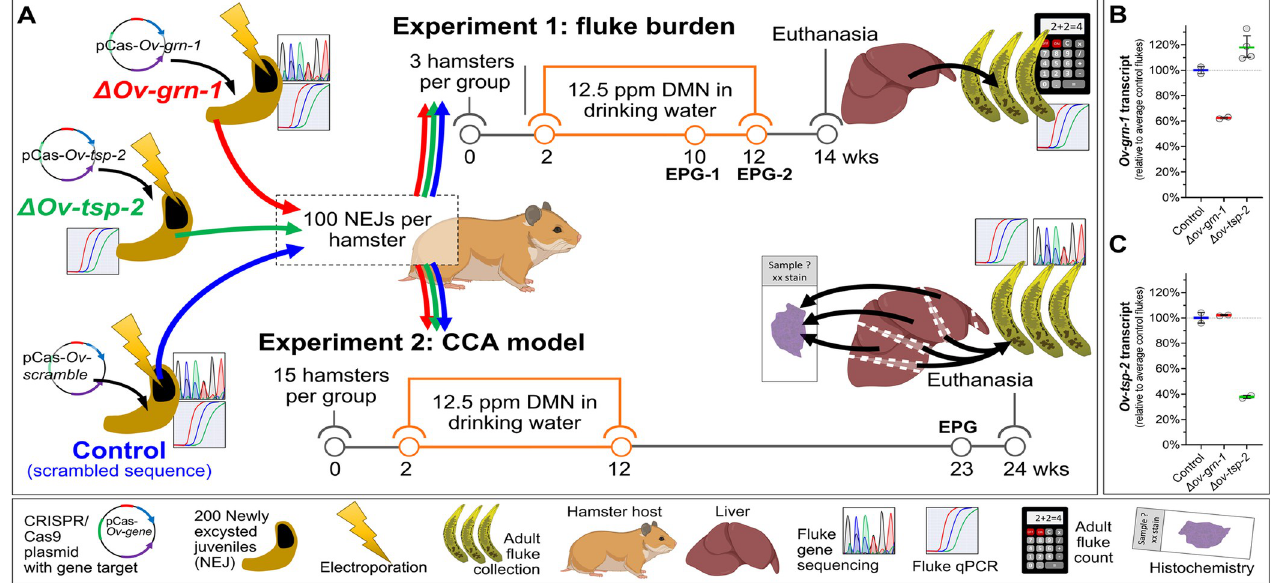
Fig 1. Schematic overview of the experimental design. Hamsters were infected with juvenile Opisthorchis viverrini worms that had been subjected to gene knockout. Two experiments were conducted. ( A ). The goal of experiment 1 was to assess the impact of CRISPR/Cas9 editing on fluke survival. The goal of experiment 2 was to assess the influence of gene knockout on pathogenesis and malignant transformation. Groups of hamsters were infected with flukes transfected with CRISPR/Cas9 plasmids targeting either Ov-grn-1 (red, Δ Ov-grn-1 ), Ov-tsp-2 (green, Δ Ov-tsp-2 ), or irrelevant guide RNA (blue, control) and exposed to dimethyl nitrosamine (DMN) in the drinking water. At timepoints indicated for each experiment, fecal egg numbers were measured as eggs per gram of feces (EPG). Experiment 1: From the livers of euthanized hamsters, all the flukes were recovered and transcript levels of the targeted genes assessed. Experiment 2: Liver lobes were sectioned and stained for histochemical analysis. Flukes incidentally released from bile ducts were collected and assessed for gene knockout. Before infection, transcript levels of Ov-grn-1 ( B ) and Ov-tsp-2 ( C ) were assessed in juvenile flukes. Transcript levels established by qPCR were plotted relative to average control transcript levels from 2–4 biological replicates; average shown with colored bar and with 95% confidence interval bars. Population statistics were generated from resampling 1000 times by replacement bootstrap analysis of untransformed delta-delta Ct values (derived from S1 Fig). (Elements of the figure include icons from BioRender.com with copyright and licensing